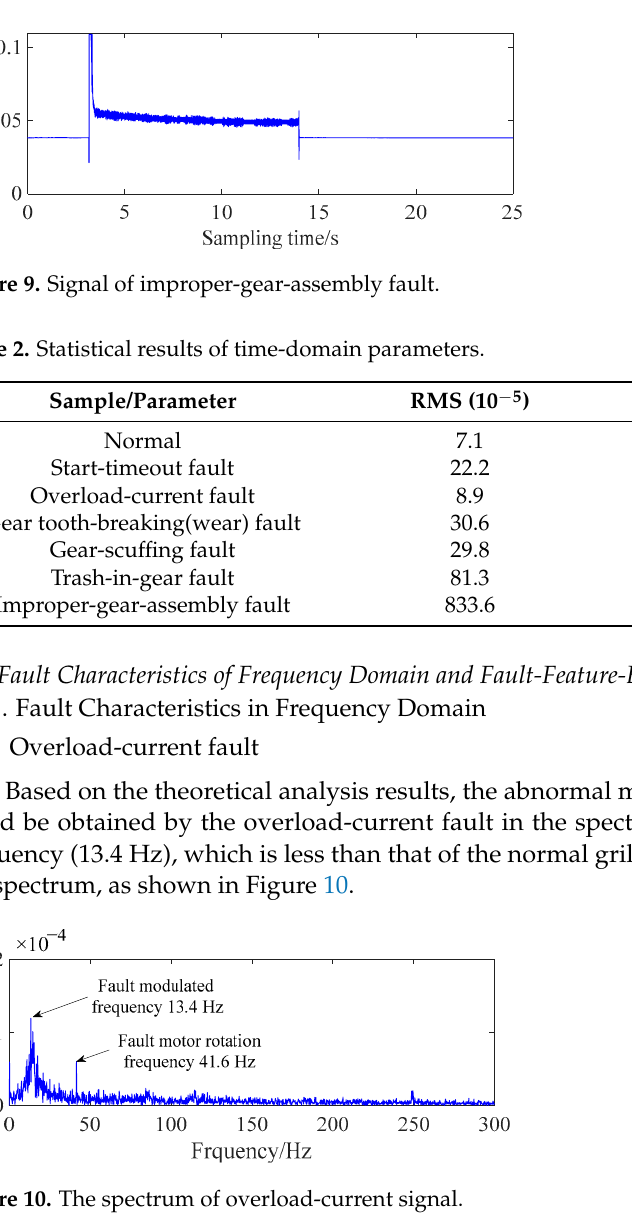
Figure 11. The local spectrum of gear-scuffing fault. 4.2.2. Fault-Feature-Extraction Method Empirical mode decomposition (EMD) [44] was proposed by Huang et al. in 1998. The complex non-stationary signal is broken down into the sum of IMFs, which are the data sequences with different feature scales. The IMF obtained by EMD contains compo- nents of the original signal in different frequency bands from high to low. The process of EMD is only related to the original signal, which has better adaptivity. In addition, EMD can be used to identify the fault information in the signal with some specific parameters, thus achieving a better effect of fault-feature extraction. However, each IMF obtained by EMD is not strictly distributed in order of frequency from largest to smallest. Therefore, a frequency crossover at each order of IMF occurs, which inevitably leads to a large number of frequency components due to over-decompo- sition. These frequency components cannot be obtained in the original signal spectrum. Only some of the IMF components can reflect the fault-feature information in the original signal, whereas the rest are spurious IMF components and noise-interference components unrelated to the original signal. It is necessary to identify and eliminate these spurious IMF components and noise interference before reconstructing to retain the fault-feature information in the original signal. Let f ( t i ) be the working-current signal of the grille controller, where i = 0, 1, ... N − 1, and N is the total number of sampling points. Then, let f j ( t i ) be the n -order IMF compo- nents of f ( t i ) obtained by EMD, where j = 1, 2, ... n . Each IMF has a different energy and correlation with the original signal. The IMFs that are sensitive to the original signal-fault- feature information should dominate the energy, whereas the spurious IMF components have smaller energy. Therefore, the correlation coefficient and energy ratios are used as the basis for spurious IMF-component screening. In addition, the fault grille controller contains more impact components. Thus, the kurtosis index is also required as a basis for IMF reconstruction. The process of the improved reconstruction method of EMD is as fol- lows: